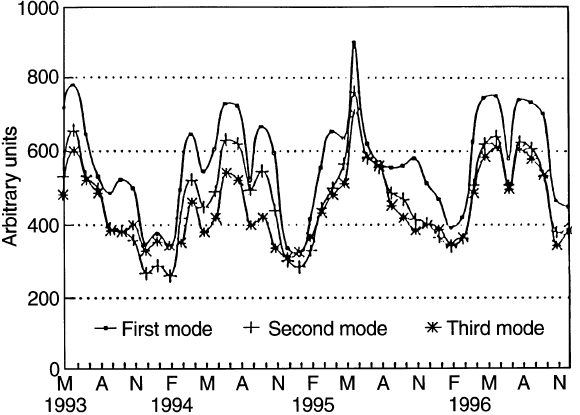
Fig. 1. Monthly means of squared relative amplitudes of the SR vertical electric component (in arbitrary units) showing the seasonal variation in the first three modes at Nagycenk station from May 1993 to December 1996